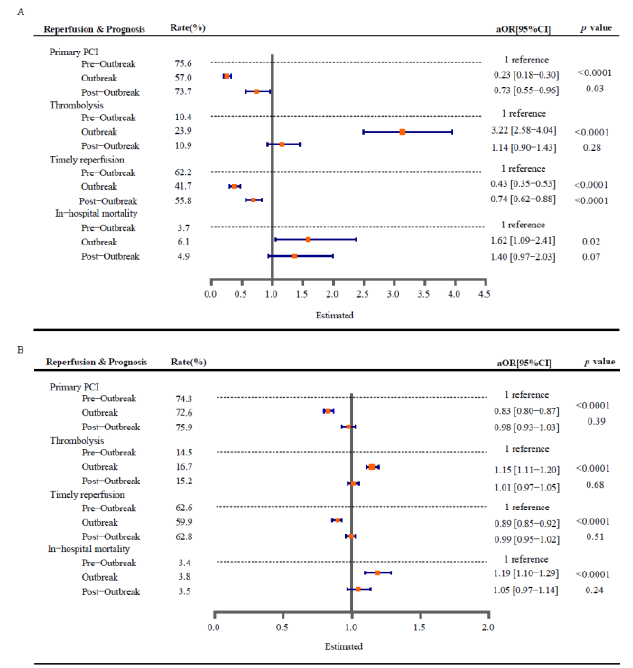
Figure 2. Impact of COVID-19 periods on changes in management and prognosis of STEMI. Regres- sion results of reperfusion patterns and in-hospital outcomes in chest pain centers in Hubei ( A ) and non-Hubei provinces ( B ), adjusted for age, sex, hypertension, diabetes, coronary heart disease, his- tory of chronic heart failure, stroke, heart rate, systolic blood pressure, and time of symptom to first medical contact. aOR, adjusted odds ratio. CI, confidential interval.